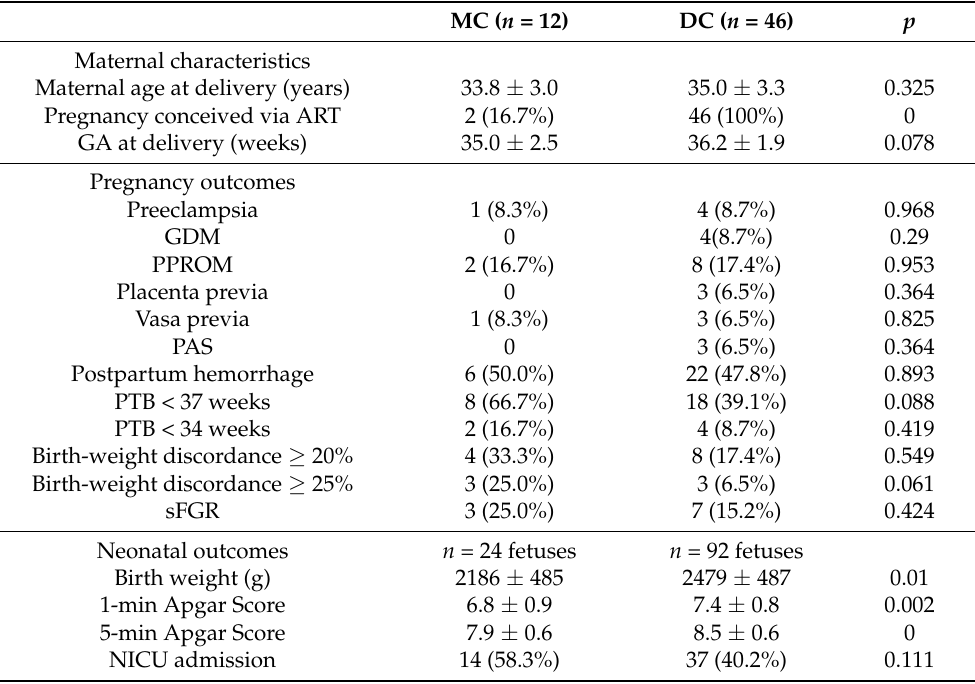
Table 2. Comparison of maternal characteristics and perinatal outcomes in twins with velamentous cord insertion according to chorionicity ( n = 58).